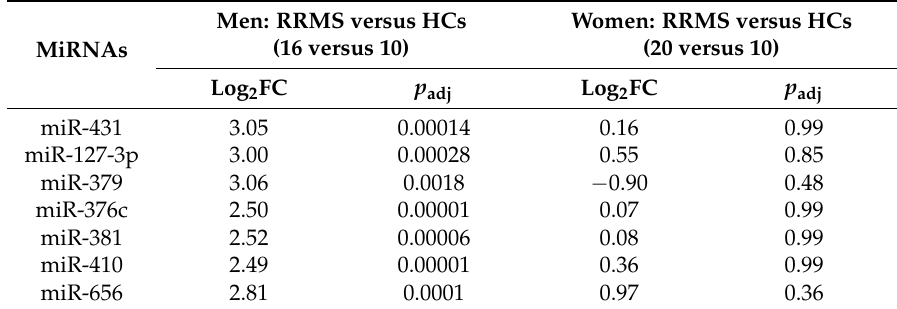
Table 3. Post-hoc analysis of differential expression of miRNAs from DLK1-DIO3 imprinted locus in peripheral blood mononuclear cells of relapsing-remitting multiple sclerosis (RRMS) patients compared to healthy controls (HCs) as determined by RT- q PCR (separately for men and women).